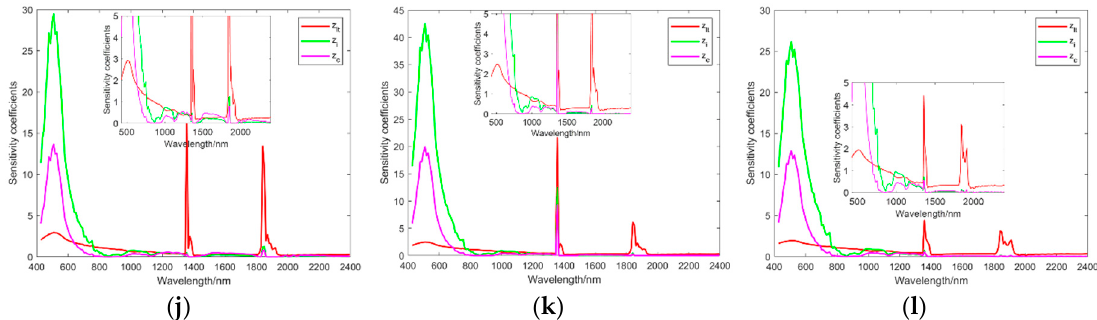
Figure 10. Uncertainty components of C correction. The subplots ( a – f ) and ( g – l ) represent the uncertainty components and sensitivity coefficients associated with input quantities of the six verification points, respectively; In each subplot of ( a – f ), the blue solid line is the total combined variance of corrected radiance after C correction; the dashed lines are the uncertainty components associated with 𝐿 (cid:3021) (red), i (green), and c (pink). In each subplot of ( g – l ), the lines are the sensitivity coefficients associated with 𝐿 (cid:3021) (red), i (green), and c (pink). Every subplot is zoomed in on y-axis as its inner plot to show local details of low-value points.